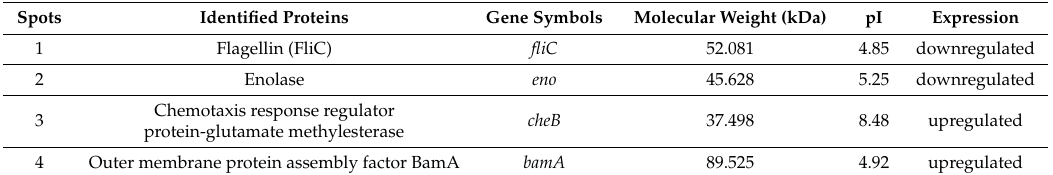
Table 3. Identification of isolated proteins from Salmonella Senftenberg 133 with resistance to both triamine-containing biocide (6 × MIC) and normal human serum